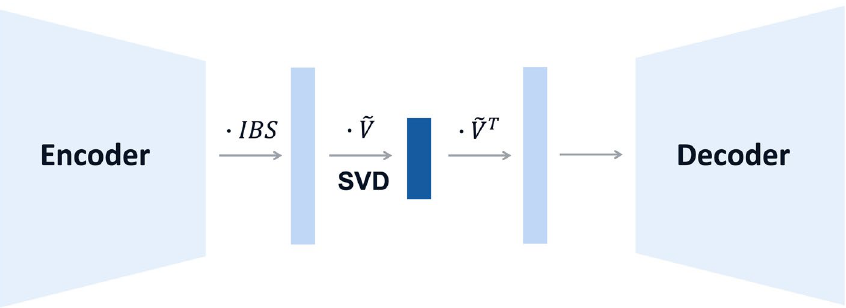
Figure 1. Network architecture of SAE-IBS. The encoder and decoder are fully connected neural networks. The decoder architecture is mirrored to the encoder architecture. Matrix multiplication is denoted by low-rank singular value decomposition. IBS is Identity-by-State similarity